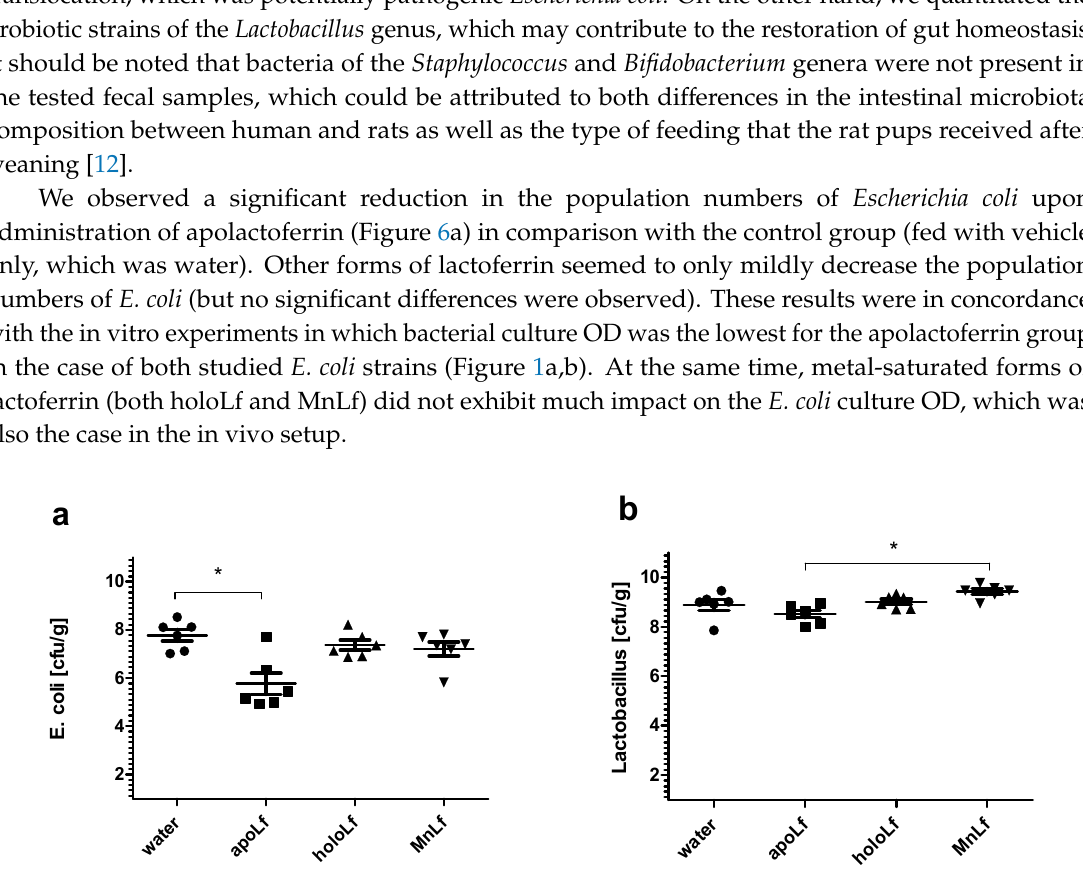
11 of 17 Figure 5. Quantitative assessment of tested strains growth after 24 h incubation with various lactoferrin forms: L. plantarum ATCC 14431 ( a ), L. plantarum PL02 ( b ), L. rhamnosus ATCC 53103 ( c ), L.